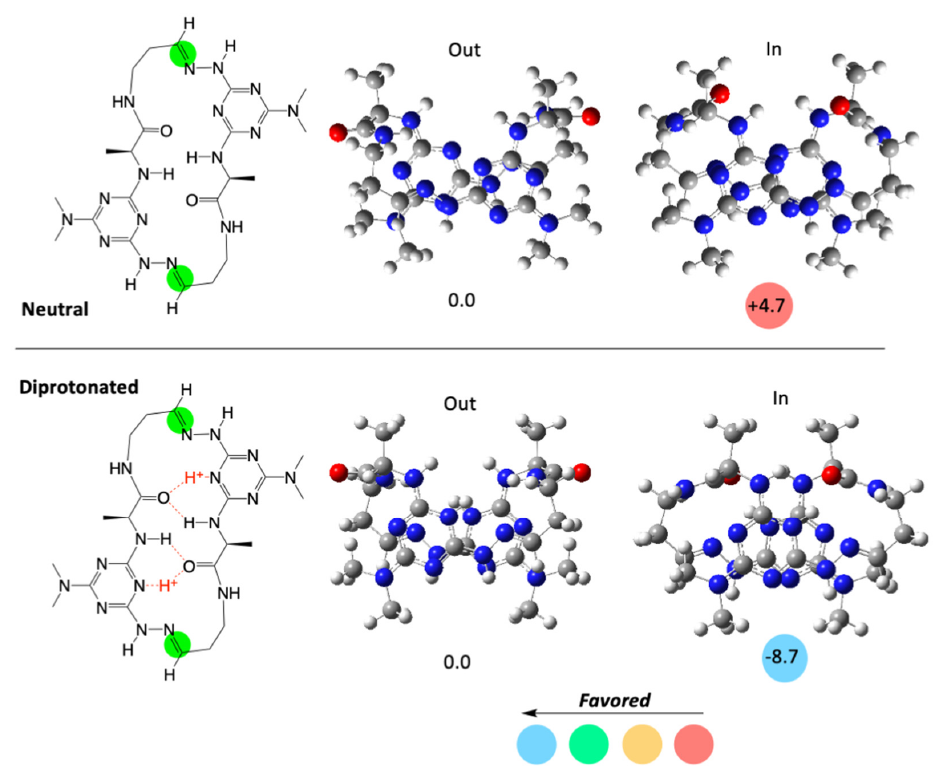
Figure 6. Computation revealed that intramolecular hydrogen bonding in the deprotonated macro- cycle was stabilizing by 8.7 kcal/mol. Color reflects the relative energetic differences with values reported in kcal/mol.